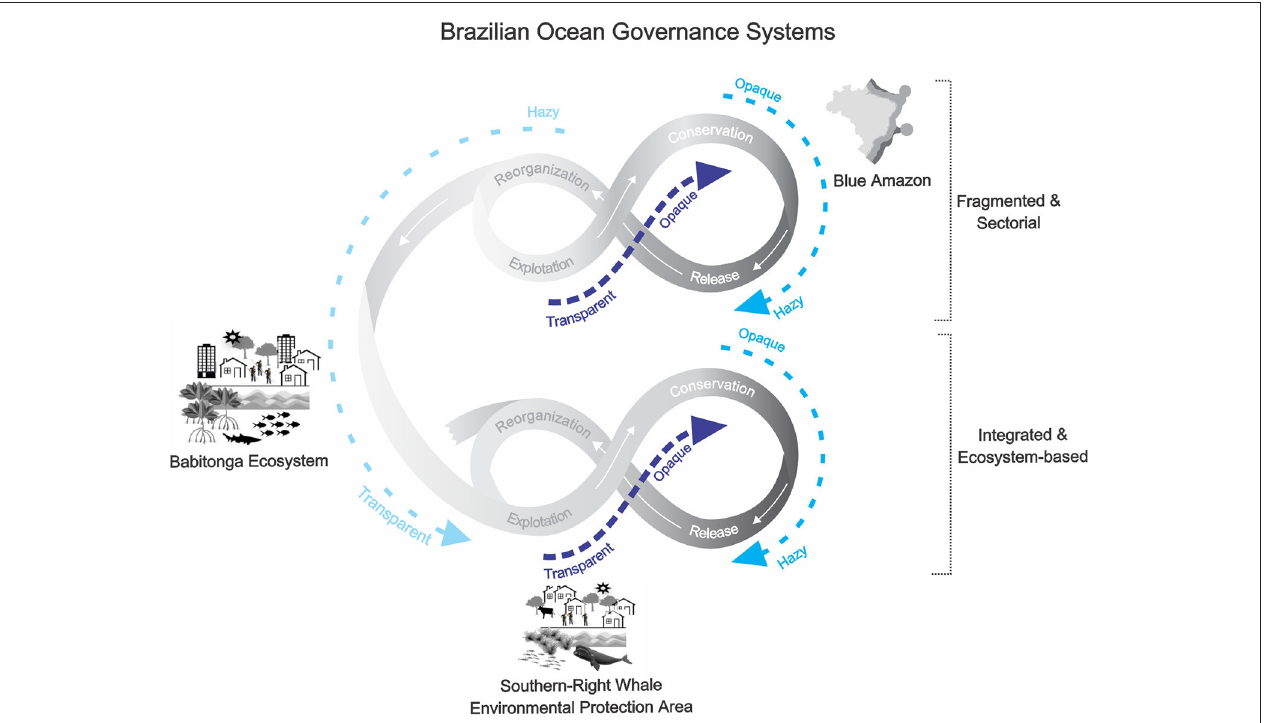
FIGURE 1 | Model of agency, context and problem domain innovation, and the shift to a new configuration of the Brazilian Ocean Governance system (adapted from Westley et al.,